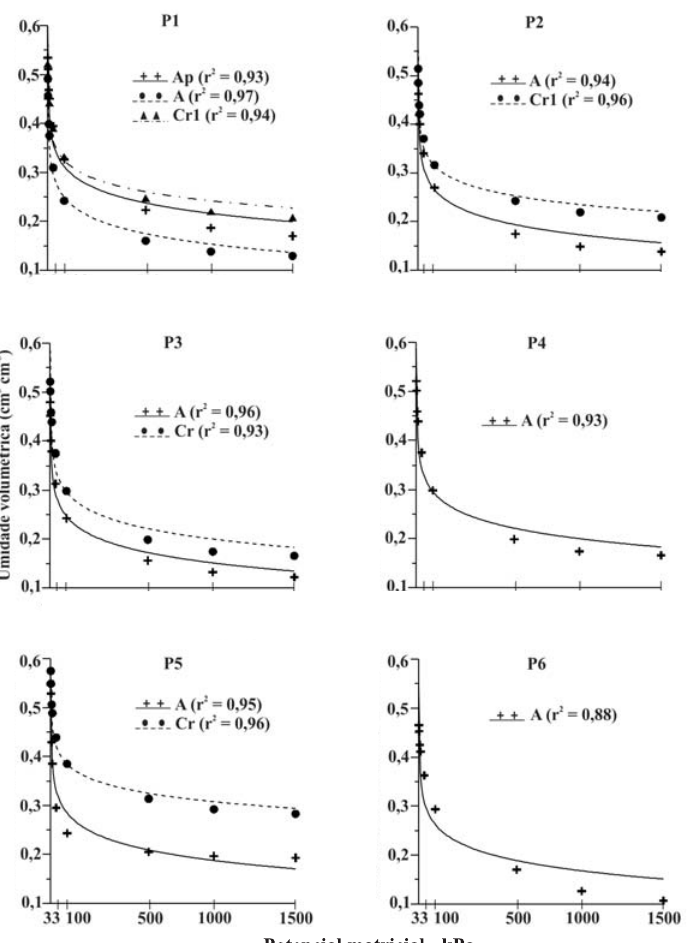
Figura 3. Curvas de retenção de água em Neossolos Litólicos e Neossolos Regolíticos derivados da Formação Caturrita no